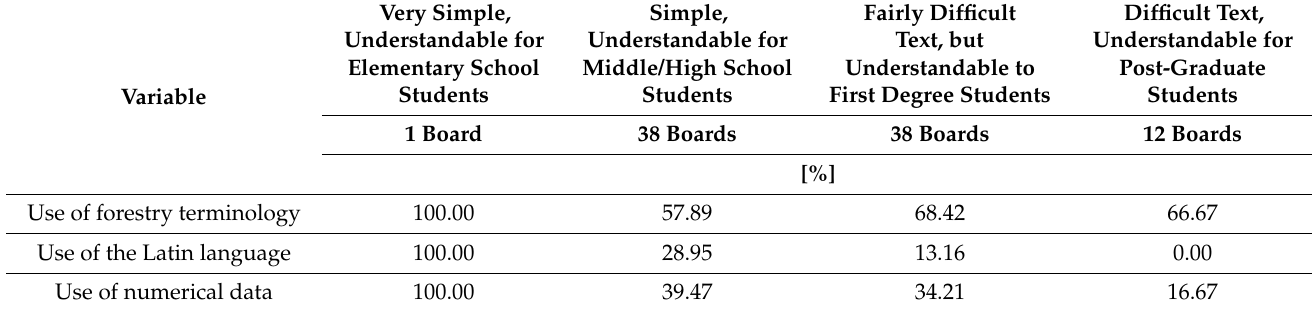
Table 5. Analysis of additional elements present in the texts of the main educational